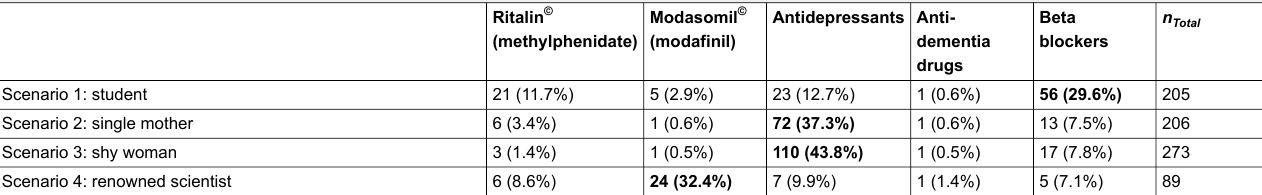
Table 4: In case of drug prescription in the last question: which of the following substances would you prescribe in the described situation (multiple answers possible)?